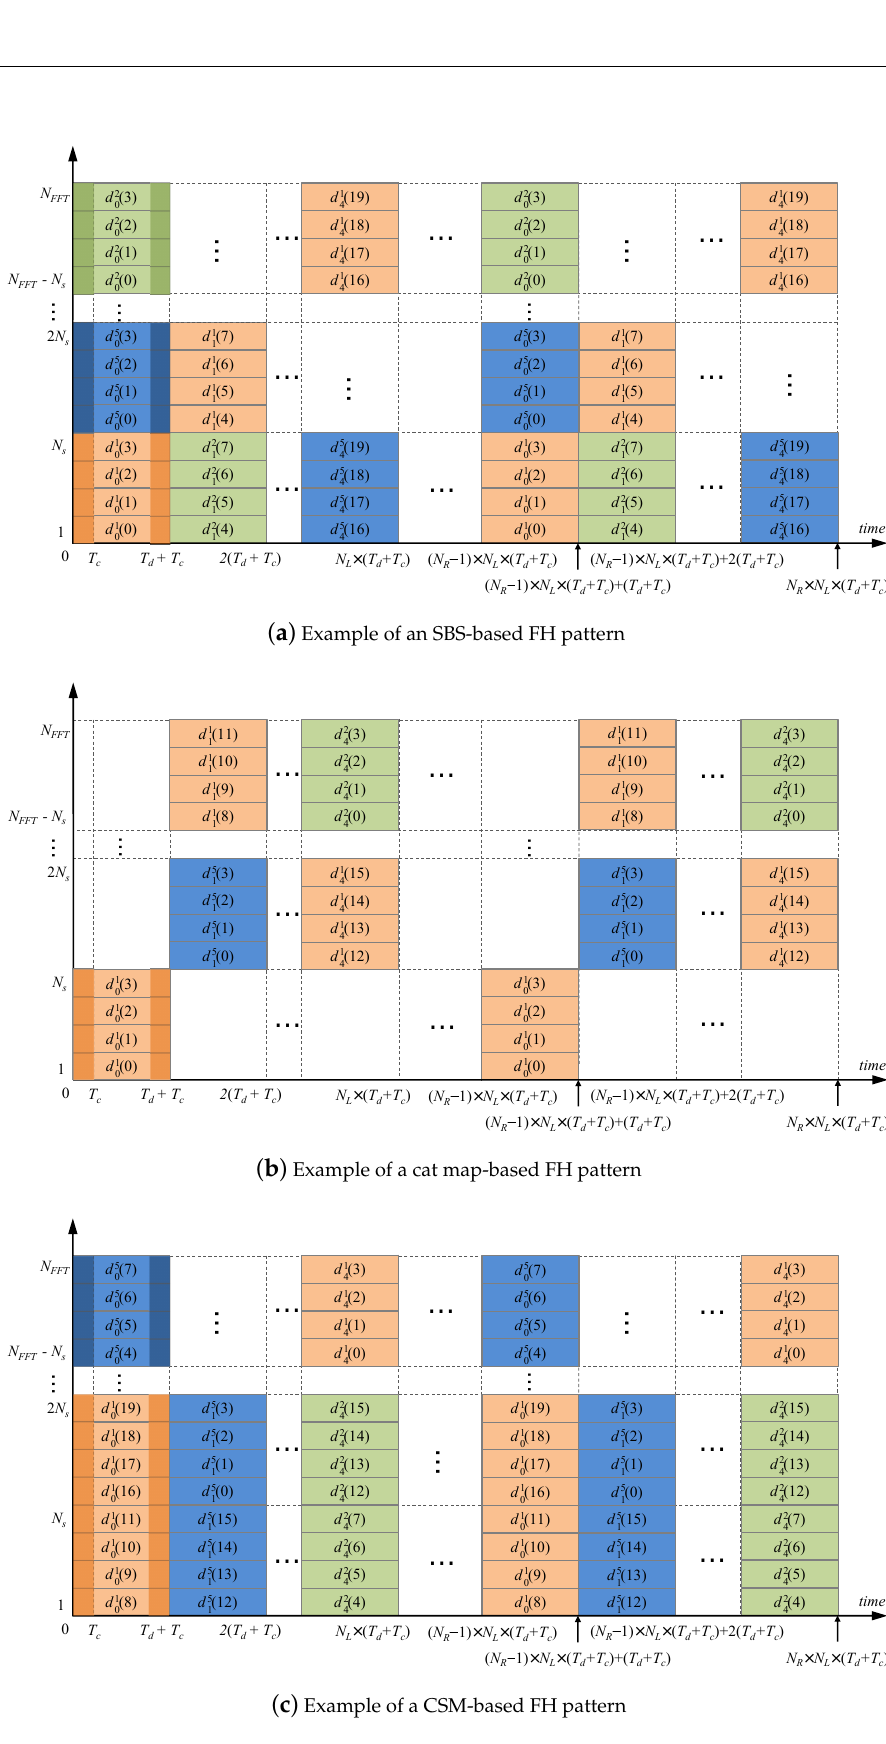
Figure 2. Comparison of symbol-by-symbol (SBS), cat map, and chaotic standard map (CSM)-based FH